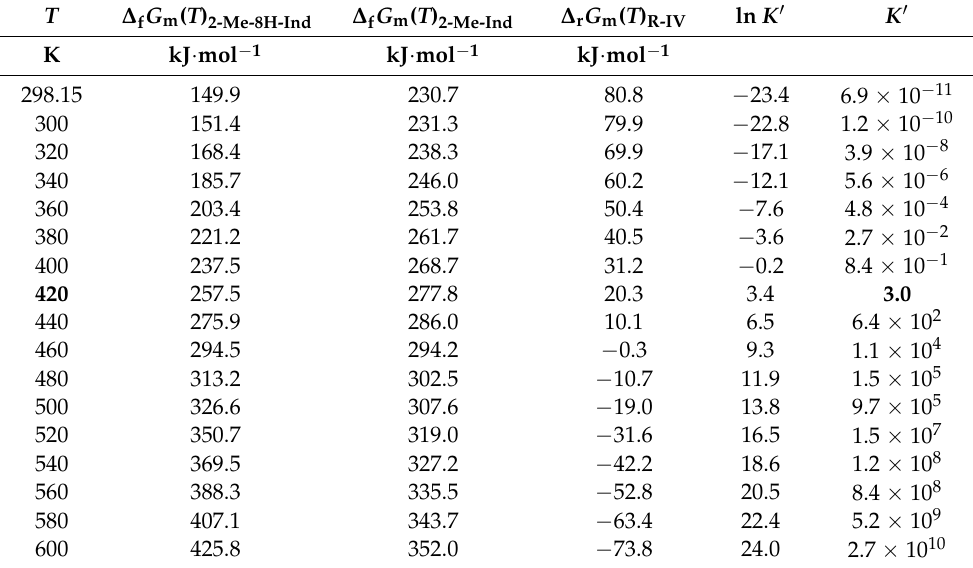
a The approximation of the ln K (cid:48) -values with the linear equation ln K (cid:48) = − 28.0 × (1000/T) + 61.1 with R 2 = 0.9997. Table 14. Gas-phase standard molar Gibbs energies of 2-methyl-8H-indole and 2-methyl-indole and thermodynamic parameters of the dehydrogenation reaction R-IV at p ◦ = 1.0 MPa a